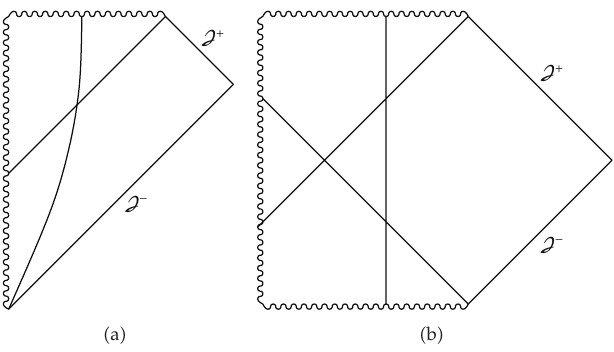
Figure 3: Penrose diagram for Λ (cid:8) 0 and (cid:2) a (cid:5) k ≤ 0; (cid:2) b (cid:5) k > 0, showing the matching surfaces and the